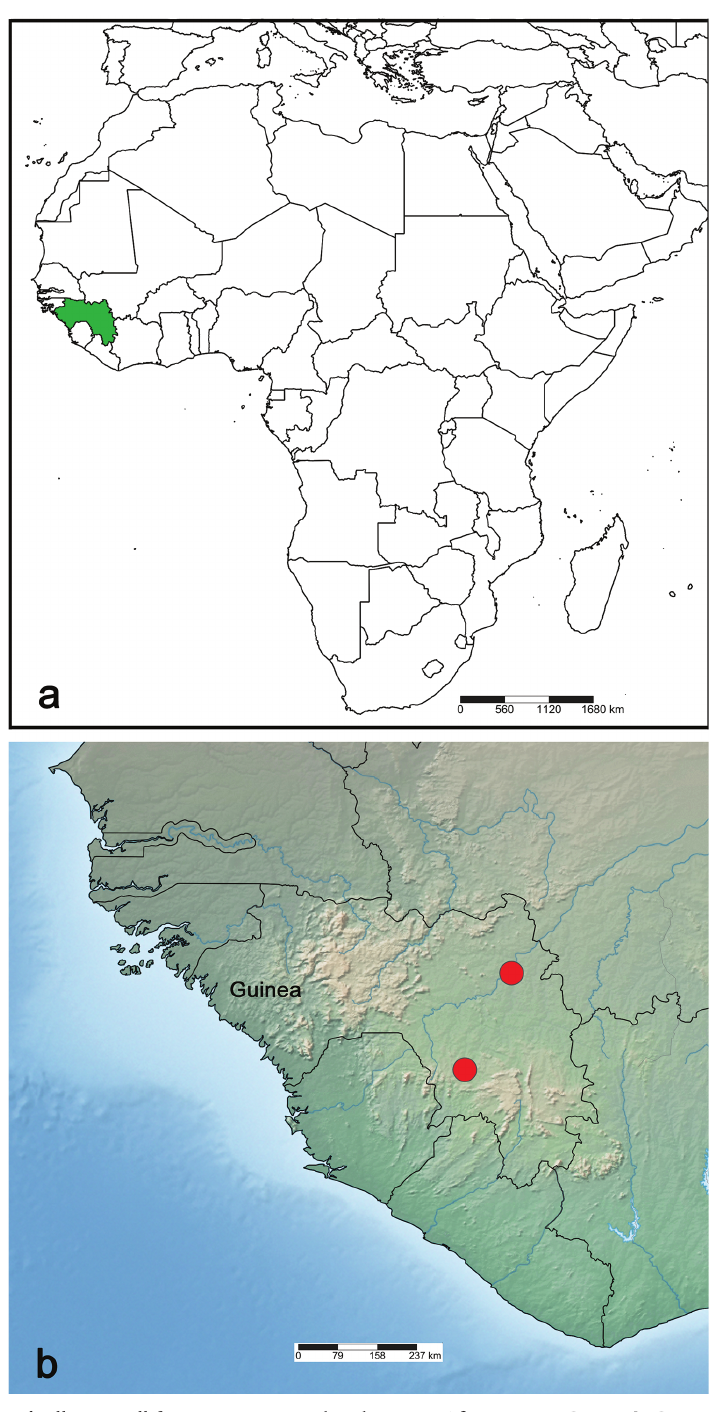
Figure 7. Pedicelliops capillifer gen. et sp. nov., distribution a Africa, green: Guinea b